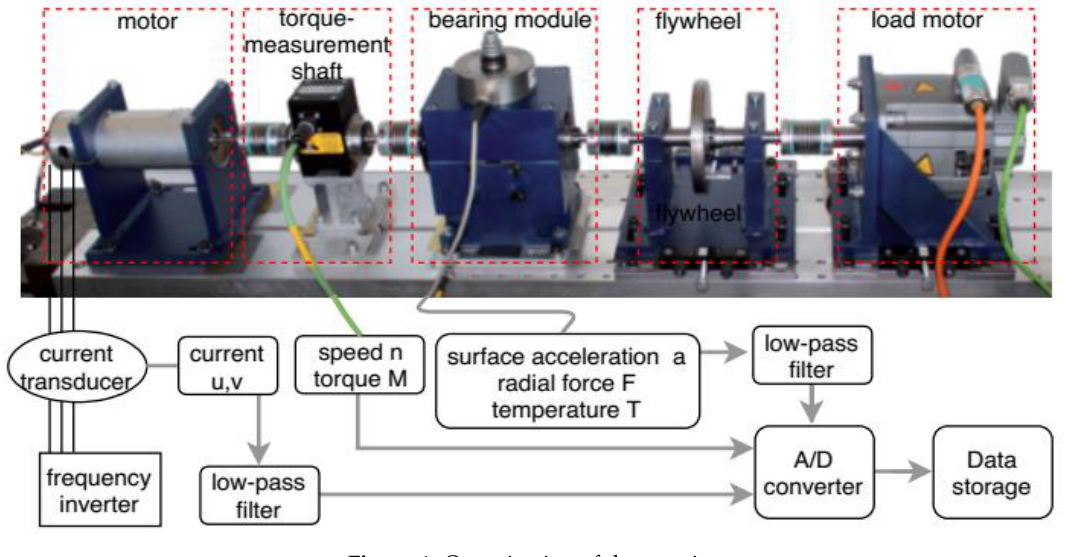
Figure 1. Organization of the test rig.